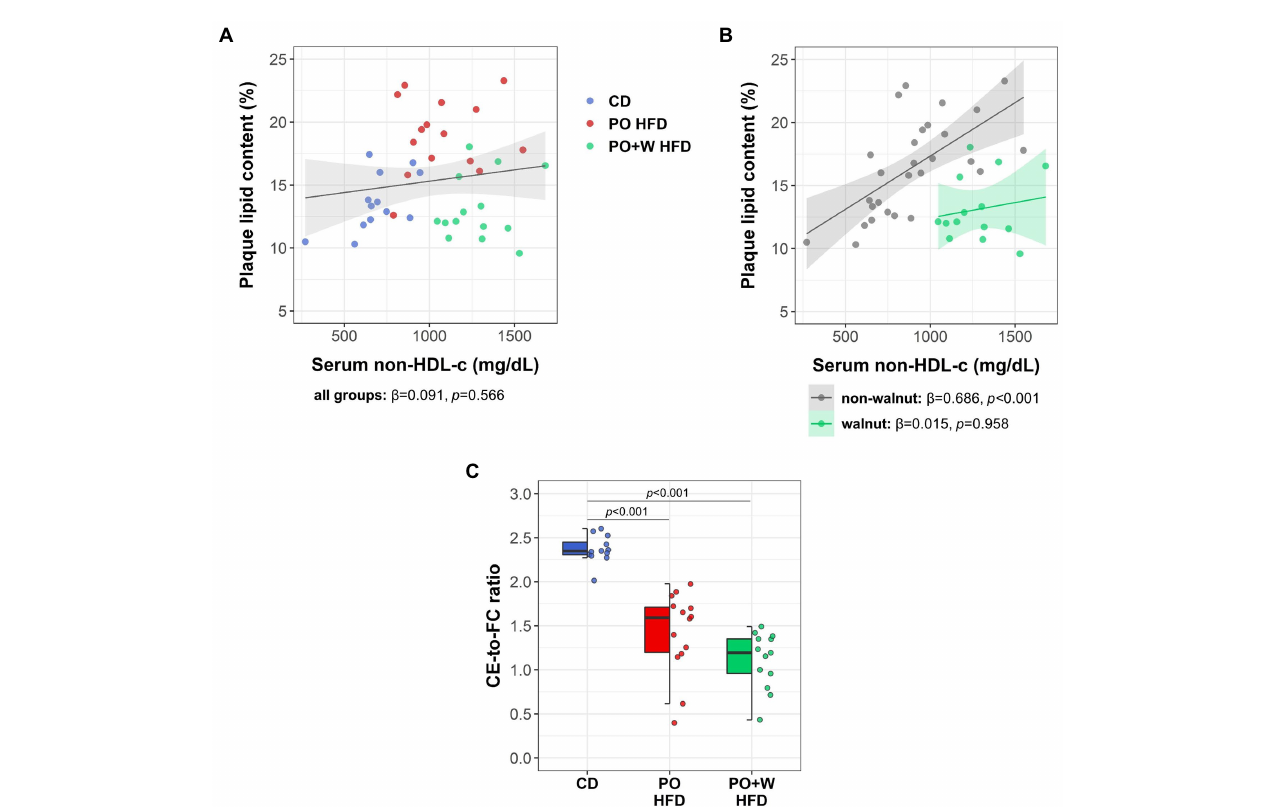
FIGURE 3 Effect of adding walnuts in the associations between serum non-HDL-c and intraplaque lipid. Scatterplots depicting the associations between serum non- HDL-cholesterol (non-HDL-c) and plaque lipid content considering all the mice together (A) and after grouping all mice into either “non-walnut intervention” (control diet and palm oil high-fat diet grouped together; grey) or “walnut intervention” (palm oil + walnuts high-fat diet, green) (B) . Lines indicate the regression line and the 95% confidence intervals for each association. The standardized regression coefficients ( β ) and the p values were computed using a linear model. (C) Ratio of serum cholesteryl ester (CE) to free cholesterol (FC). Dot and box plots show individual values and depict the median (horizontal bar), interquartile range (IQR, hinges) and 1.5 × IQR (whiskers). CD, control diet ( n = 14); PO HFD, palm oil-based high-fat diet ( n = 15); PO + W HFD, palm oil + walnuts high-fat diet (isocaloric inclusion of 3% of walnuts at expense of palm oil, n = 14). p values obtained by one-way ANOVA (after log-transformation) with Bonferroni post hoc